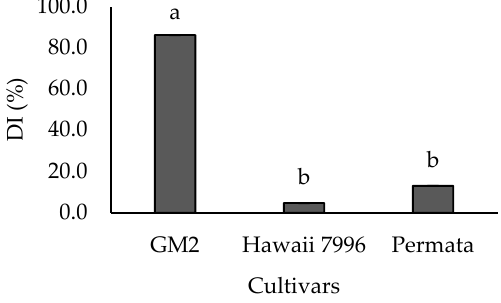
Figure 1. Disease Intensity (DI) of three cultivars tomatoes treated with Ralstonia solanacearum. Bars with the same letter were not significantly different at p = 0.05 based on Tukey’s HSD tests. Bars show the average disease intensity from 5 replicates.